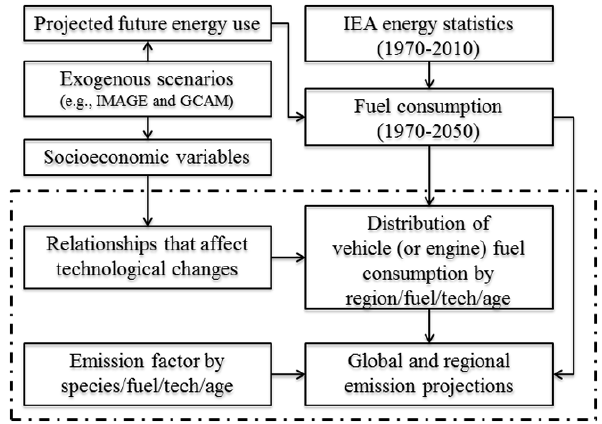
Figure 1. Schematic methodology for developing projections of ex- haust emissions from on-road vehicles and non-road engines. Parts in the dashed rectangular box are handled by the SPEW-Trend model. The exogenous scenarios are from an integrated assessment model